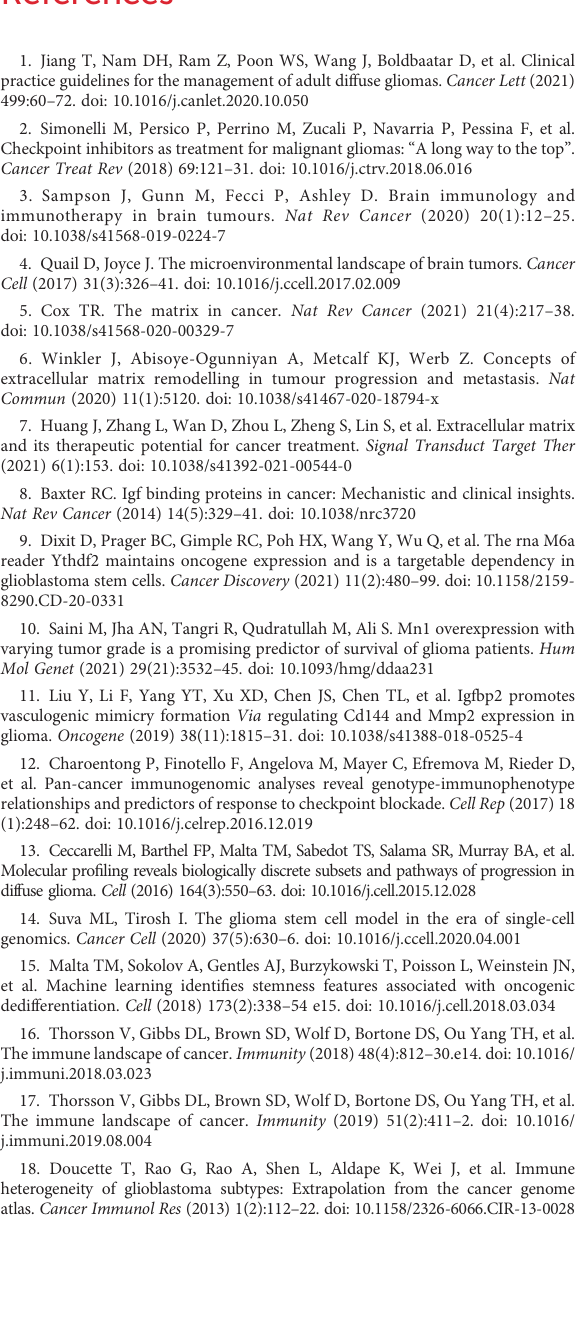
SUPPLEMENTARY FIGURE 3 Comparison of mutated genes in high- and low- riskscore groups. (A-P) The histogram showed mutanted genes with signi fi cant differences of the waterfall plots.